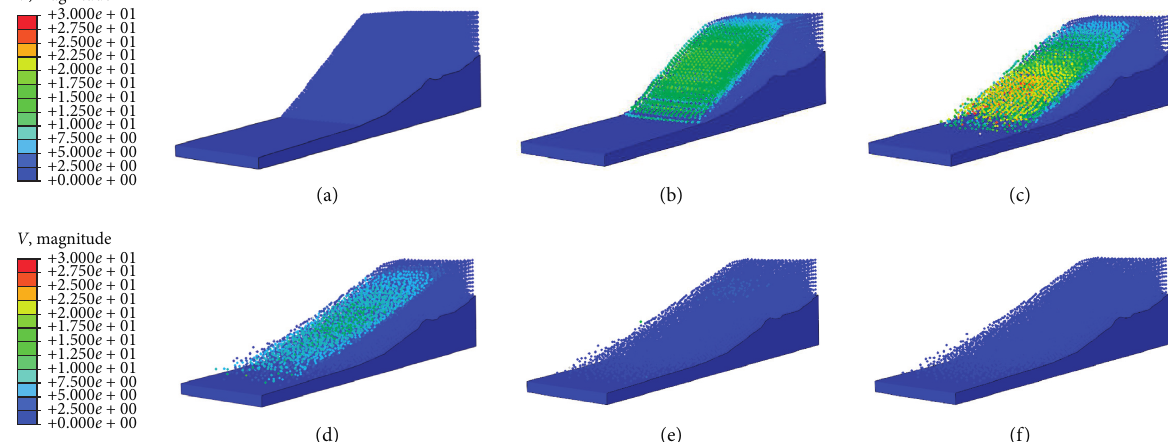
Figure 18: The velocity (Vmagnitude) and shapes of the landslides at different times (number of particles: 11700). (a) t � 0 s. (b) t � 8 s. (c) t � 17 s. (d) t � 30 s. (e) t � 40 s. (f) t � 100